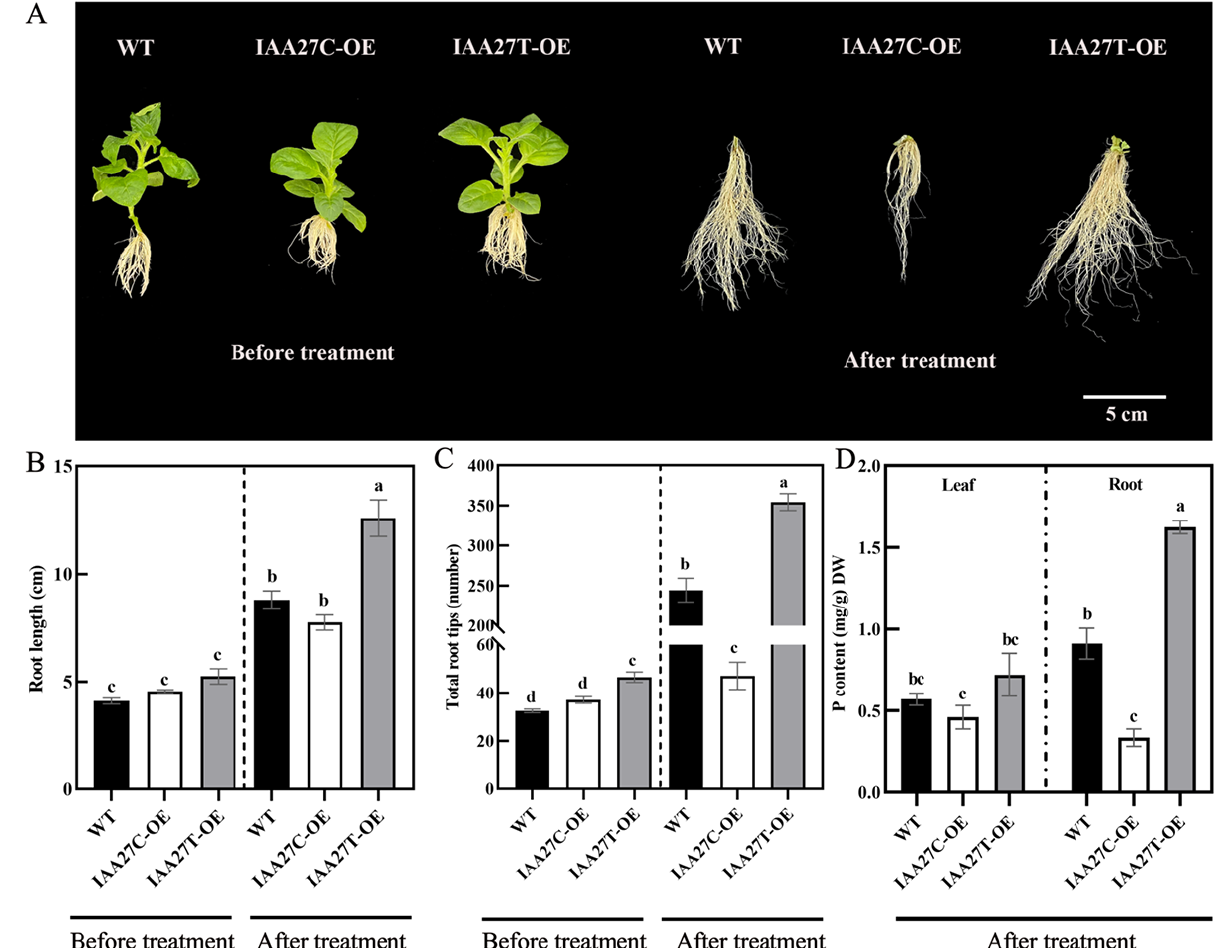
Figure 3. Ectopic expression of MdIAA27 influenced tolerance to phosphate stress in transgenic tobacco. ( A ) The phenotypes of MdIAA27 transgenic and WT tobacco in the presence of auxin (0.5 mol/L) for 15 days on MS solid medium. ( B , C ) Statistical analysis of total root tips and root lengths. ( D ) Phosphorus content of transgenic and WT lines after treatment with LP (10 μM KH 2 PO 4 ) for 10 days. Different letters represent significant differences ( p < 0.05). Error bars show standard deviation (s.d.) from three biological replicates.